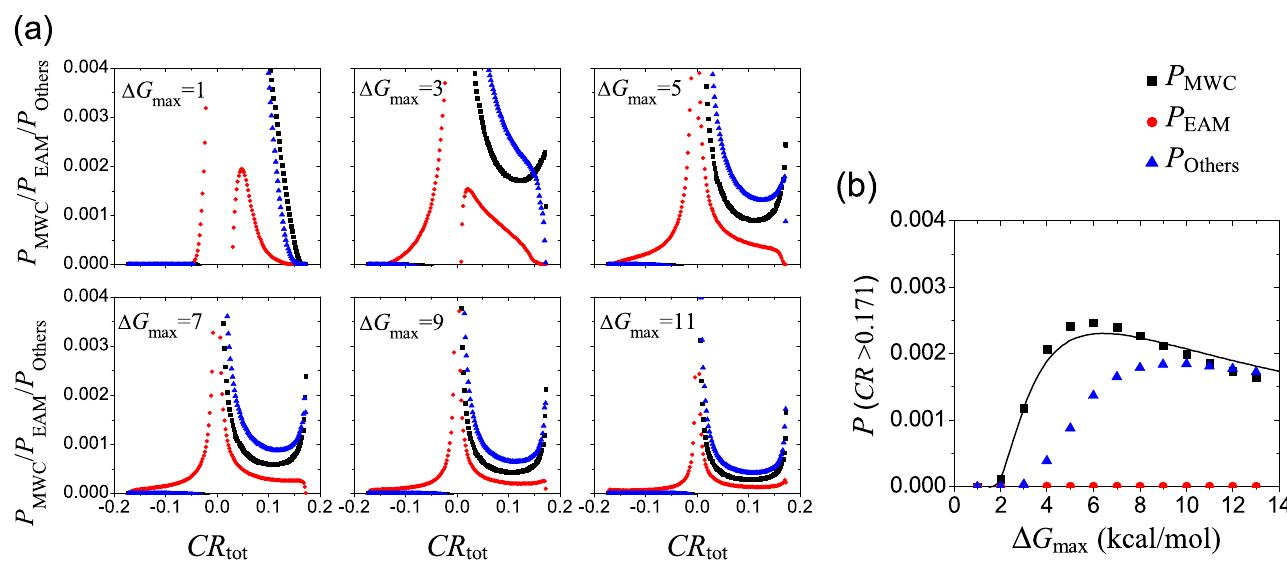
Fig 7. The influence of the variation range ( Δ G max , in a unit of kcal/mol) for free-energy parameters ( Δ G R1 , Δ G R2 , Δ G RT1 , Δ G RT2 , Δ g int,R , Δ g int,T ) of the comprehensive ensemble model with the A-R binding mode. (a) The possibilities for three pathways [calculated with Eq (12)] obtained at different [– Δ G max , + Δ G max ] range. (b) The probabilities of CR > 0.171 as a function of Δ G max